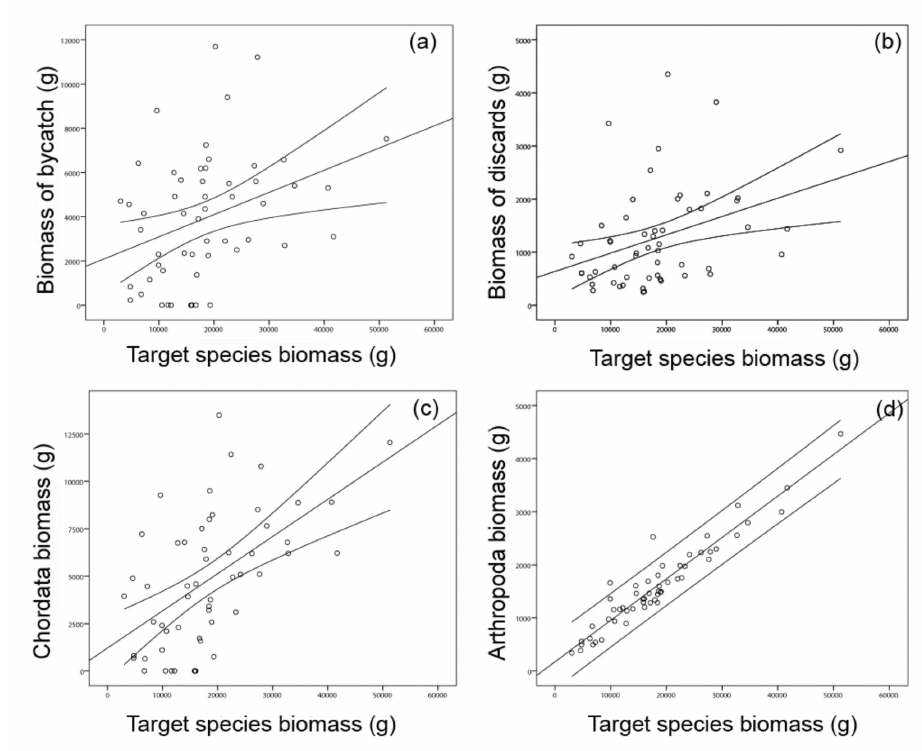
Figure 5. Scatter plots depicting the relationship between target species’ biomass to the biomass of ( a ) incidental catch, ( b ) discards, Chordata ( c ) and Arthropoda ( d ). The linear regression and 95% confidence intervals are